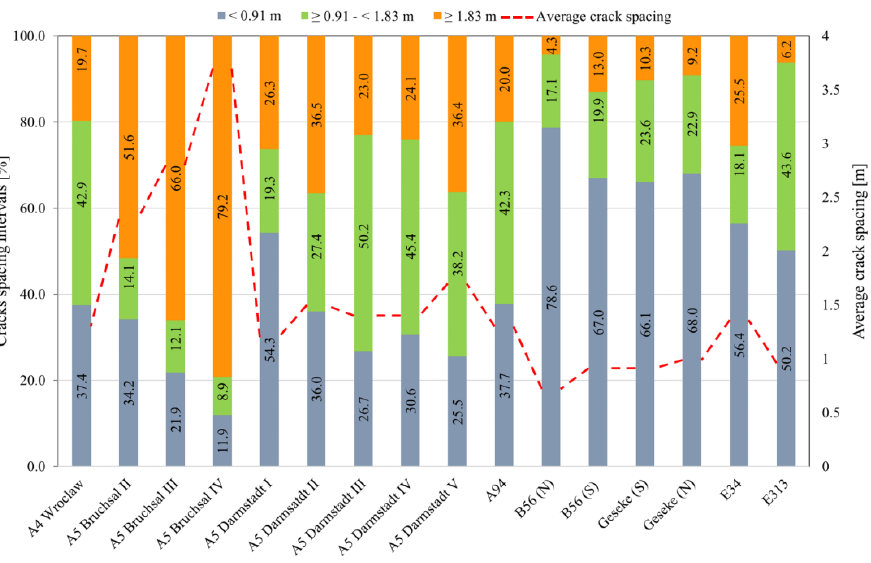
Figure 3. Classification of the crack spacing of the studied sections.